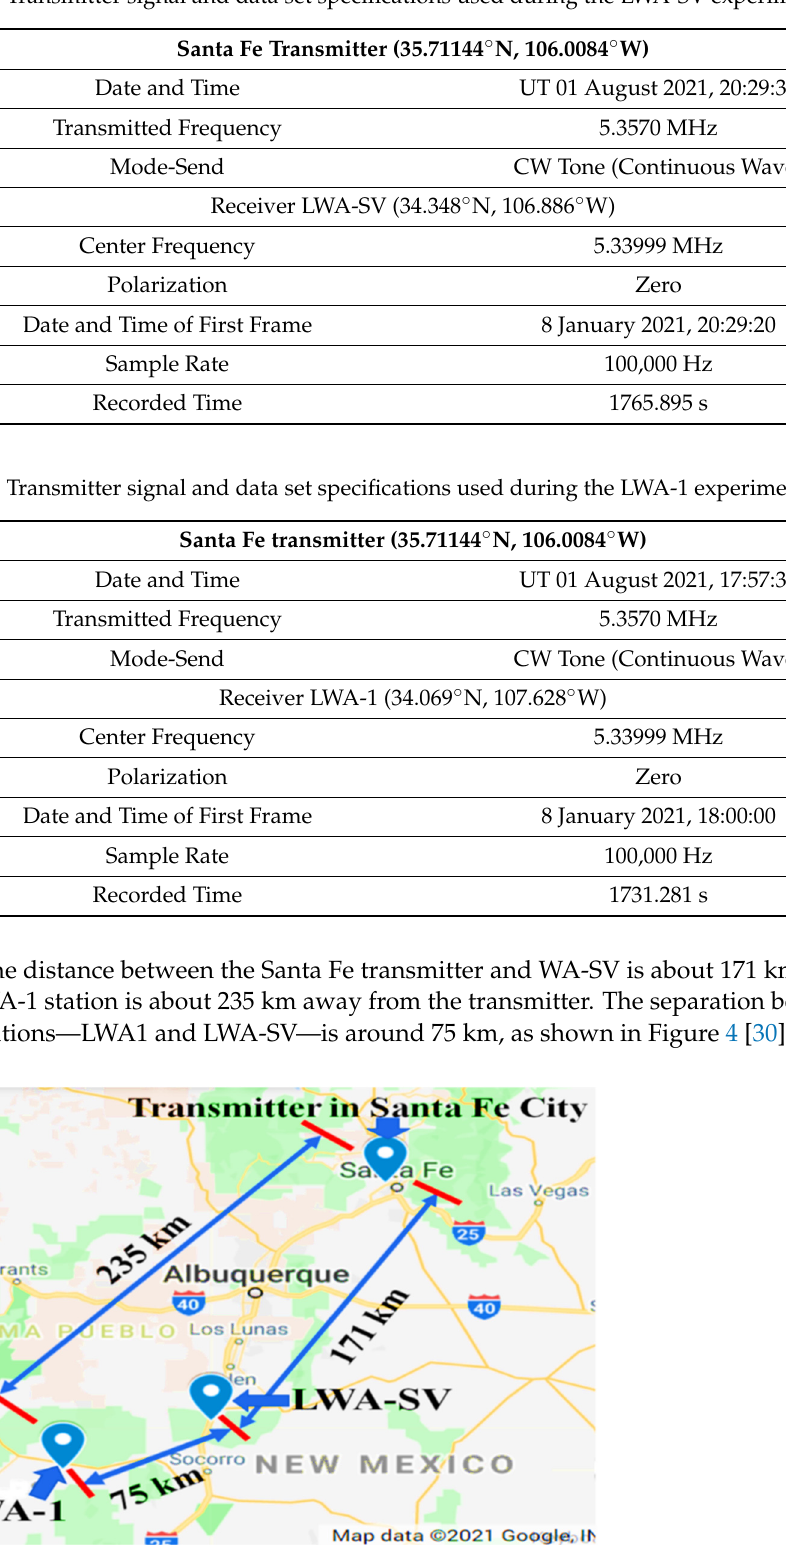
Figure 4. The distance between the transmitter and both LWA stations as well as the distance be- tween LWA −1 and